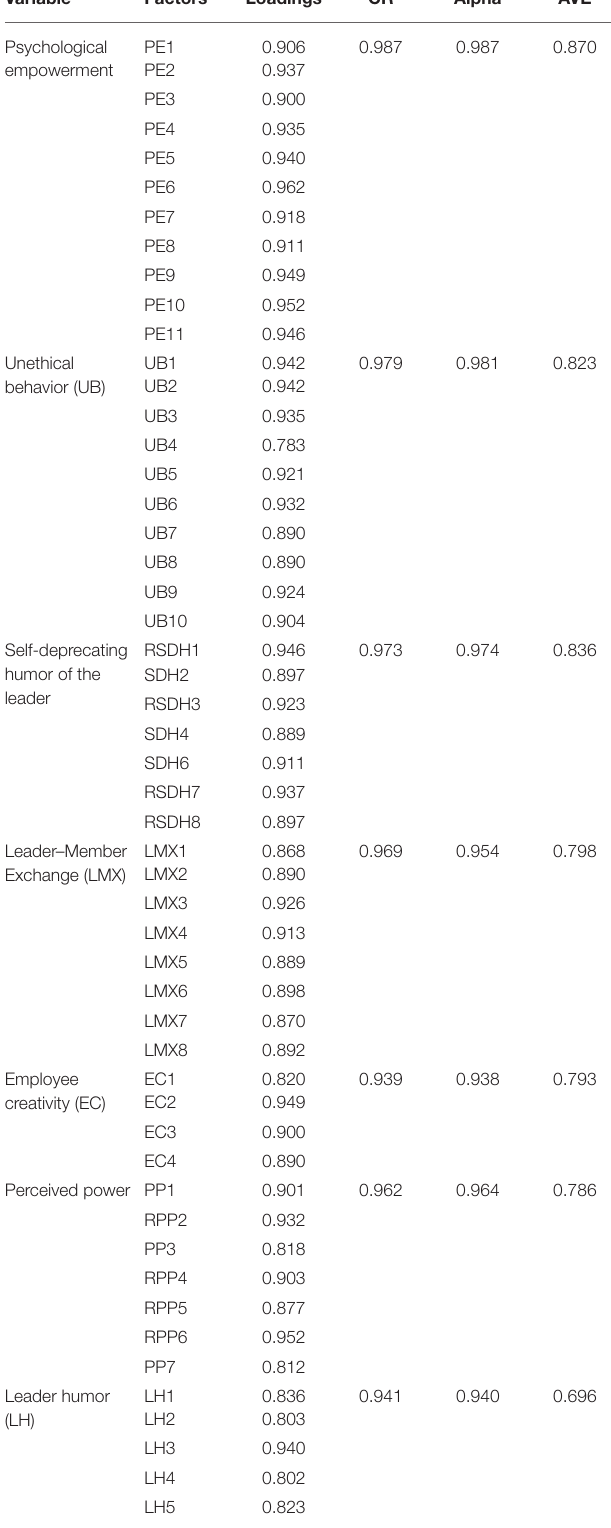
TABLE 2 | Validity and reliability